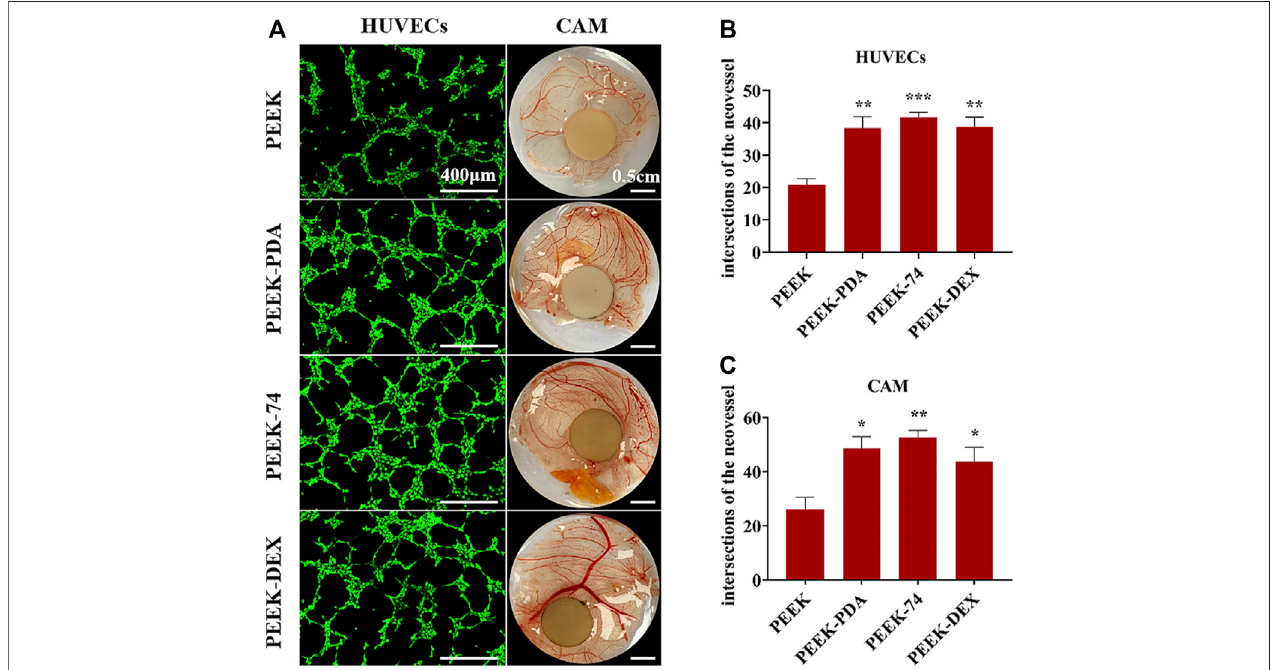
FIGURE9| BloodvesselformationofdifferentPEEKsamples. (A) PicturesofHUVECsangiogenesisassayandvivoCAMassay;thenumberofintersectionsofthe neovessel network: (B) HUVECs and (C) CAM; * p < 0.05, ** p < 0.01, and *** p < 0.001 (Xiao et al., 2021). Copyright 2021, American Chemical Society.